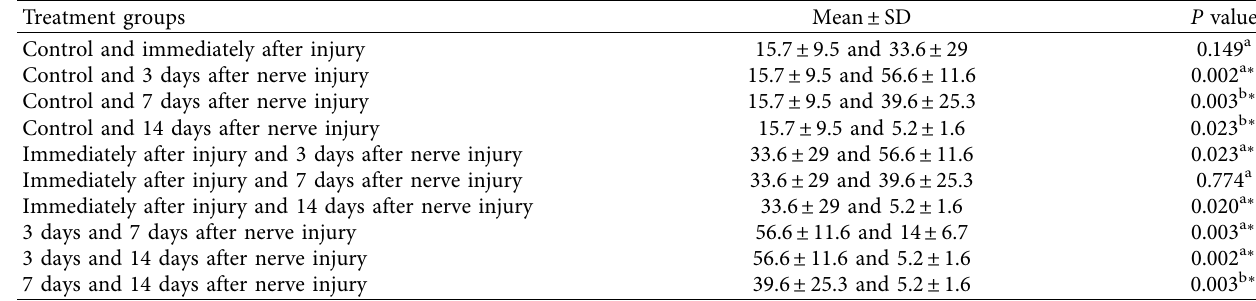
Table 4: Post hoc analysis comparing various groups of treatment with respect to endoneurium vacuoles found on histopathologic analysis. Treatment